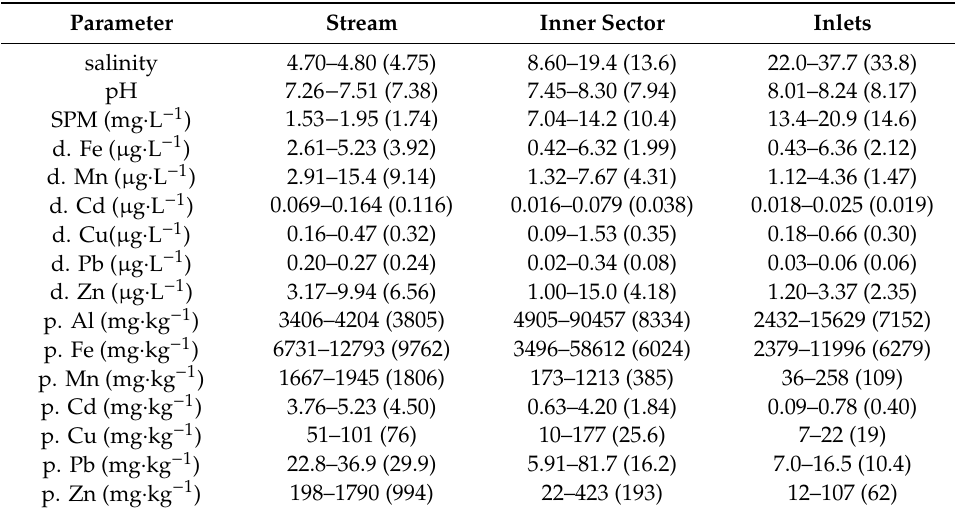
Table 2. Ranges (min–max) and median values (in parenthesis) of salinity, pH, SPM and dissolved (d.) and particulate (p. in w / w) metals in the three sectors of the Antinioti Lagoon system, during both sampling